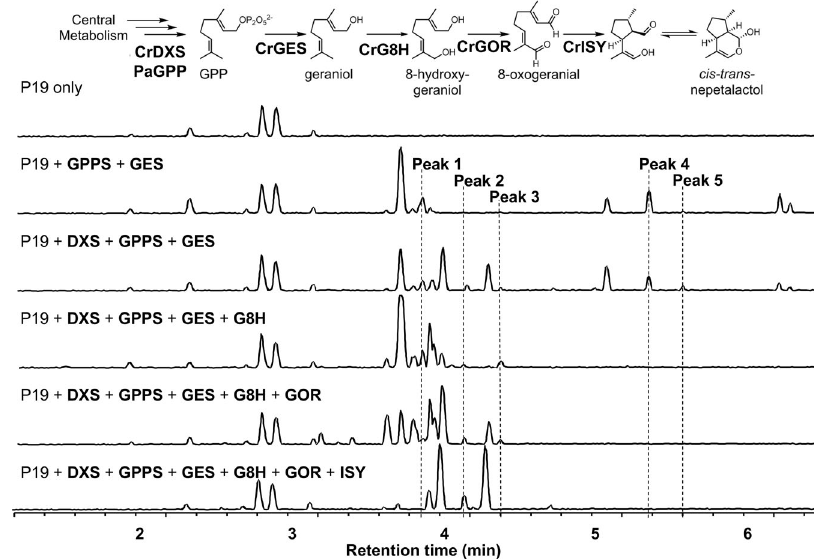
Fig. 1 Metabolites of the early iridoid pathway are derivatized by endogenous enzymes from N. benthamiana . A common modi fi cation was the addition of pentose and hexose sugars e.g., Peak 1, hexosyl hydroxygeraniol [M + HCOOH-H], 3.84 min, m/z 377.1817; Peak 2, hexosyl hydroxycitronellal [M + HCOOH-H], 4.12 min, m/z 379.1974; Peak 3, trihexosyl geranic acid [M + HCOOH-H], 4.35 min, m/z 699.2703); Peak 4, pentosyl hexosyl geraniol [M + HCOOH-H], 5.32 min, m/z 493.2288; Peak 5, acetyl dihexosyl geraniol [M-H], 5.454 min, m/z 519.2445; DXS, 1-deoxy-D-xylulose 5-phosphate synthase; GPPS, geranyl diphosphate synthase; GES, geraniol synthase; G8H, geraniol 8-oxidase; GOR, 8-hydroxygeraniol oxidoreductase; ISY, iridoid